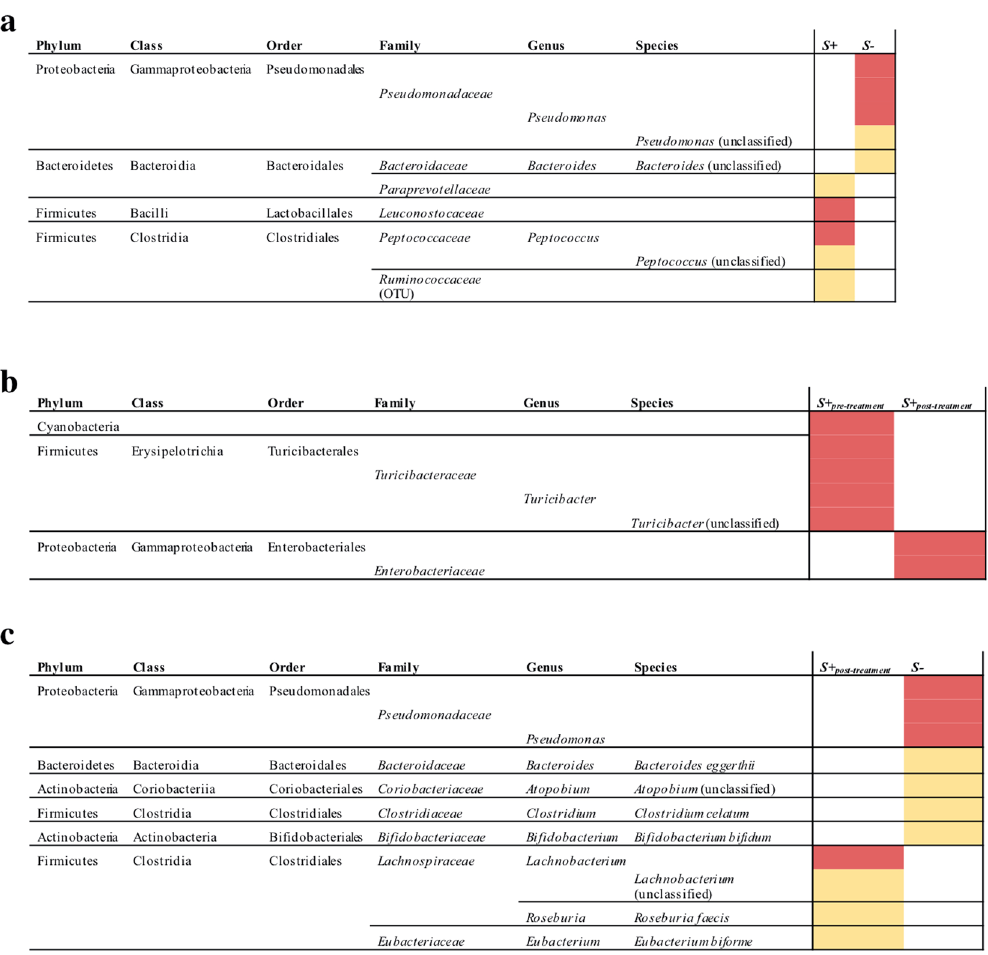
Figure 4. Differentially abundant bacterial taxa in the faecal microbiota of Strongyloides stercoralis ( a ) infected and uninfected subjects ( S + and S − , respectively), ( b ) infected subjects pre- and post anthelmintic treatment with ivermectin ( S + pre-treatment and S + post-treatment , respectively), and ( c ) infected subjects post-anthelmintic treatment and uninfected subjects ( S + post-treatment and S − respectively), based on Linear discriminant analysis Effect Size (LEfSe) analysis. Colours correspond to Linear Discriminant Analysis (LDA) scores of 4 or higher (red) and 3.5 to 4